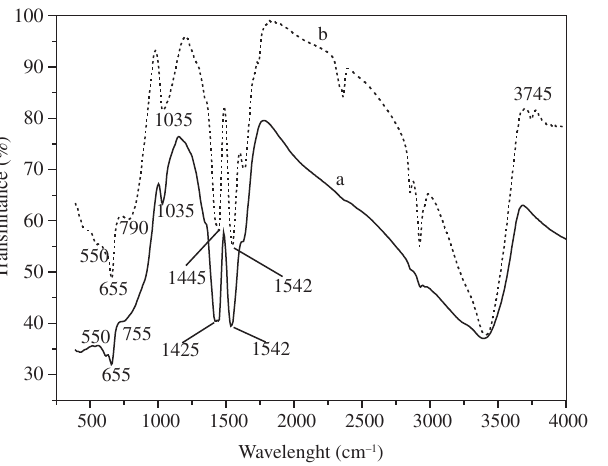
Figure 4. FT-IR spectra: a) TiO